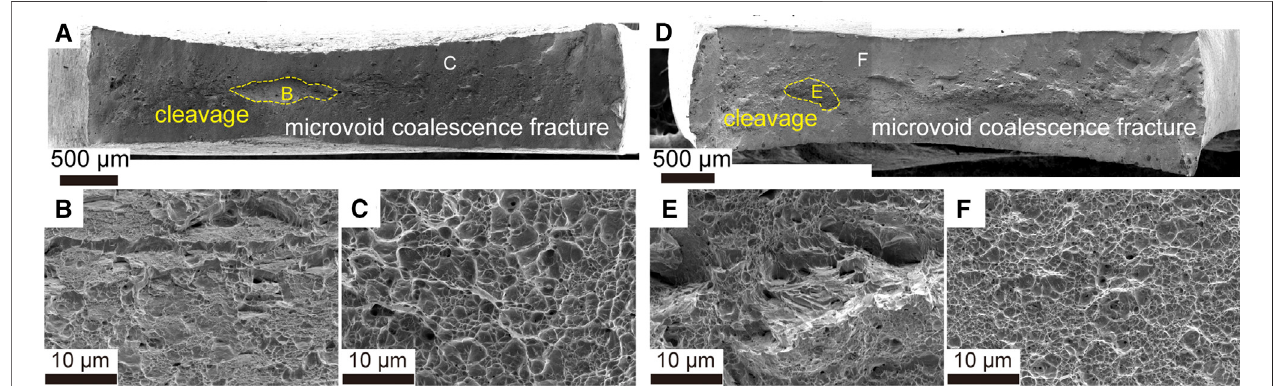
FIGURE 8 | Fractography of SSRT tests on (A) – (C) the uncharged 22MnB5 steel and (D) – (F) the uncharged 34MnB5V steel.